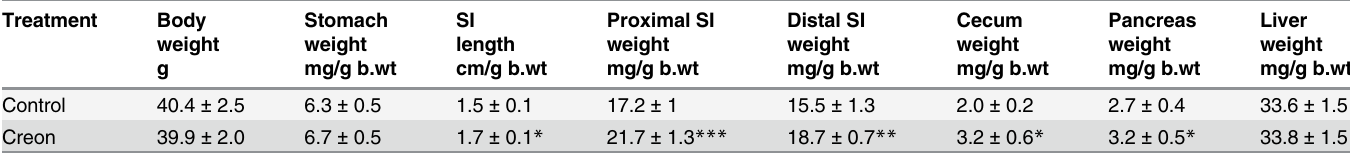
Table 1. Body weight and gut organ growth of 17 d-old rats after gavage feeding with pancreatic enzyme preparation, Creon, or α -lactalbumin (control) during 14 – 16 days of age. Treatment